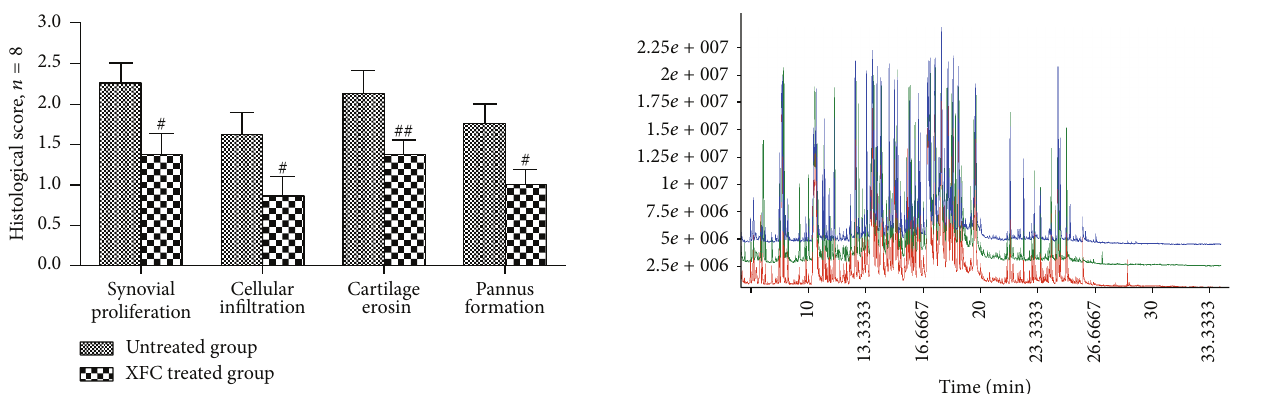
Figure3:TICchromatogramofurinesamplesinAArats;thebrown line represents healthy group; the green line represents untreated group; the blue line represents XFC treated